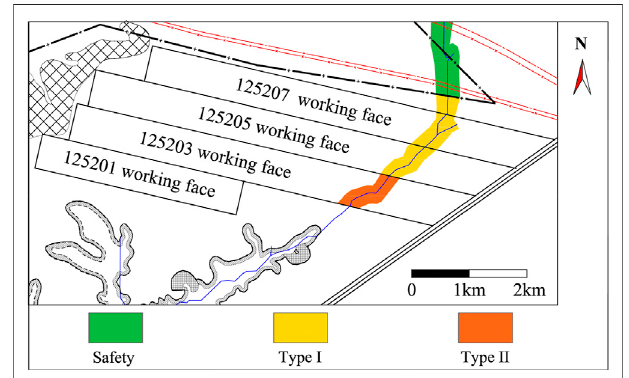
FIGURE 9 | Predicted safety zoning of the 5 − 2 coal overburden fi ssure.